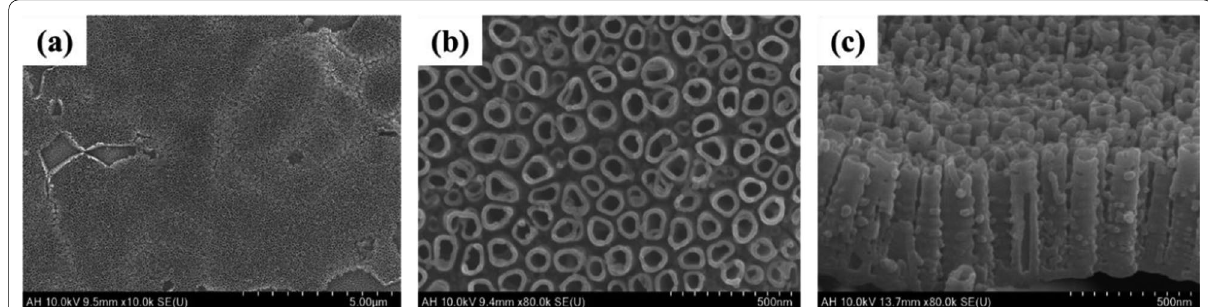
Fig. 1 Field emission scanning electron microscope (FE‑SEM) images of a Ti–6Al–4V ELI alloy plate of the AH group. a Top view with 10 k magnification, b Top view with 80 k ×